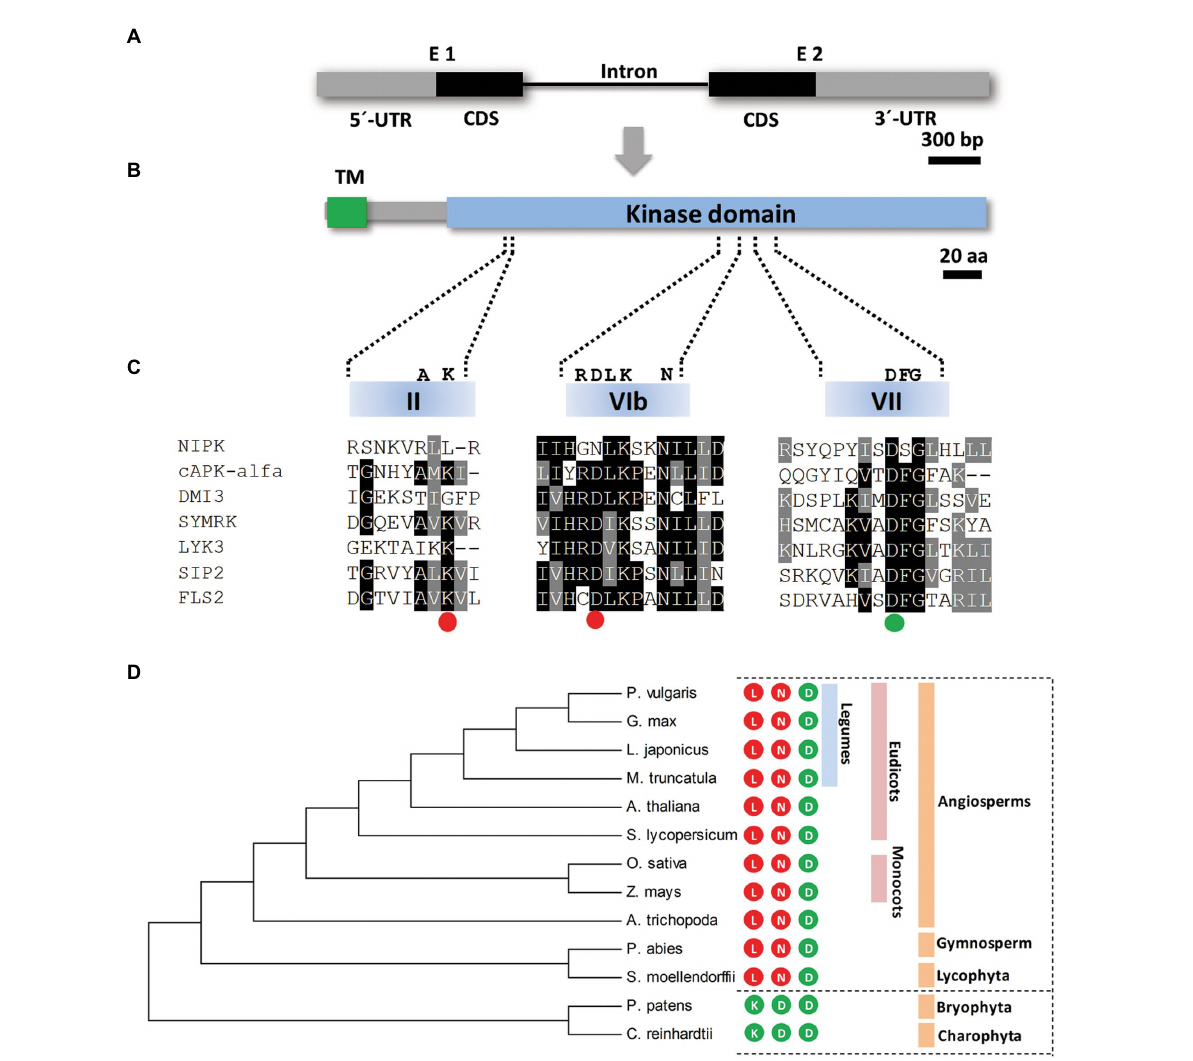
FIGURE 1 NIPK encodes a protein pseudokinase. (A,B) Schematic representation of the NIPK gene (A) and the encoded protein (B) . Gray boxes correspond to 5 ′ and 3 ′ untranslated regions (UTR) and black boxes correspond to coding sequence regions. The black line indicates the only intron present in the NIPK gene. The putative transmembrane (TM) and the kinase domains of the protein are shown in green and light blue, respectively. (C) A multiple sequence alignment of motives VAIK (II subdomain), HRD (VIb subdomain), and DFG (VII subdomain) of the kinase domain of NIPK and the functional kinases DMI3 (Gleason et al., 2006), SYMRK (Yoshida and Parniske, 2005), LIK3 (Jayaraman et al., 2017), SIP2 (Chen et al., 2012), FLS2 (Lu et al., 2010), and cPKA-alfa. The colored circles indicate whether each of the three amino acids (K, D, and D) required for the phosphotransfer reaction are conserved (green) or not (red) in NIPK. (D) Phylogenetic tree generated with the amino acidic sequences of P. vulgaris NIPK and its putative orthologs from Medicago truncatula , Arabidopsis thaliana , Lotus japonicus , Glycine max , Amborella trichopoda , Solanum lycopersicum , Zea mays , Oryza sativa, Selaginella moellendorffii, Picea abies, Physcomitrella patens , and Chlamydomonas reinhardtii . The phylogenetic tree was generated using MEGA7. Numbers represent bootstrap values obtained from 1,000 trials. The colored circles indicate whether each of the three amino acids required for the phosphotransfer reaction (K, D, and D) are present (green) or not (red) in the amino acid sequence of NIPK orthologs in each